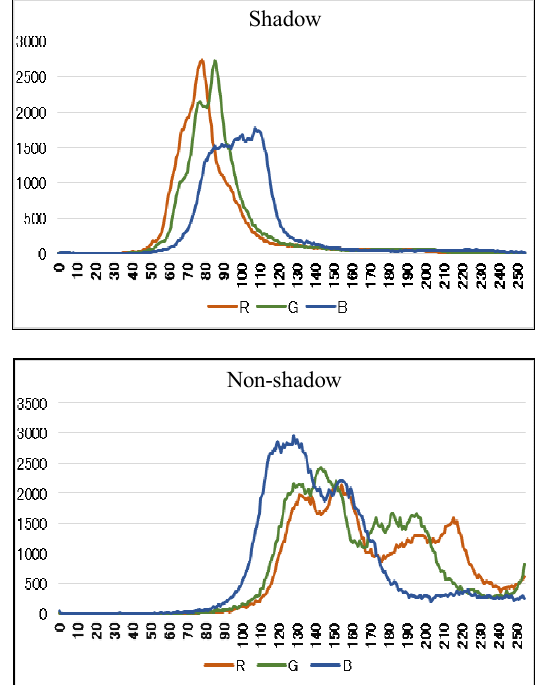
Figure 13. Brightness correction